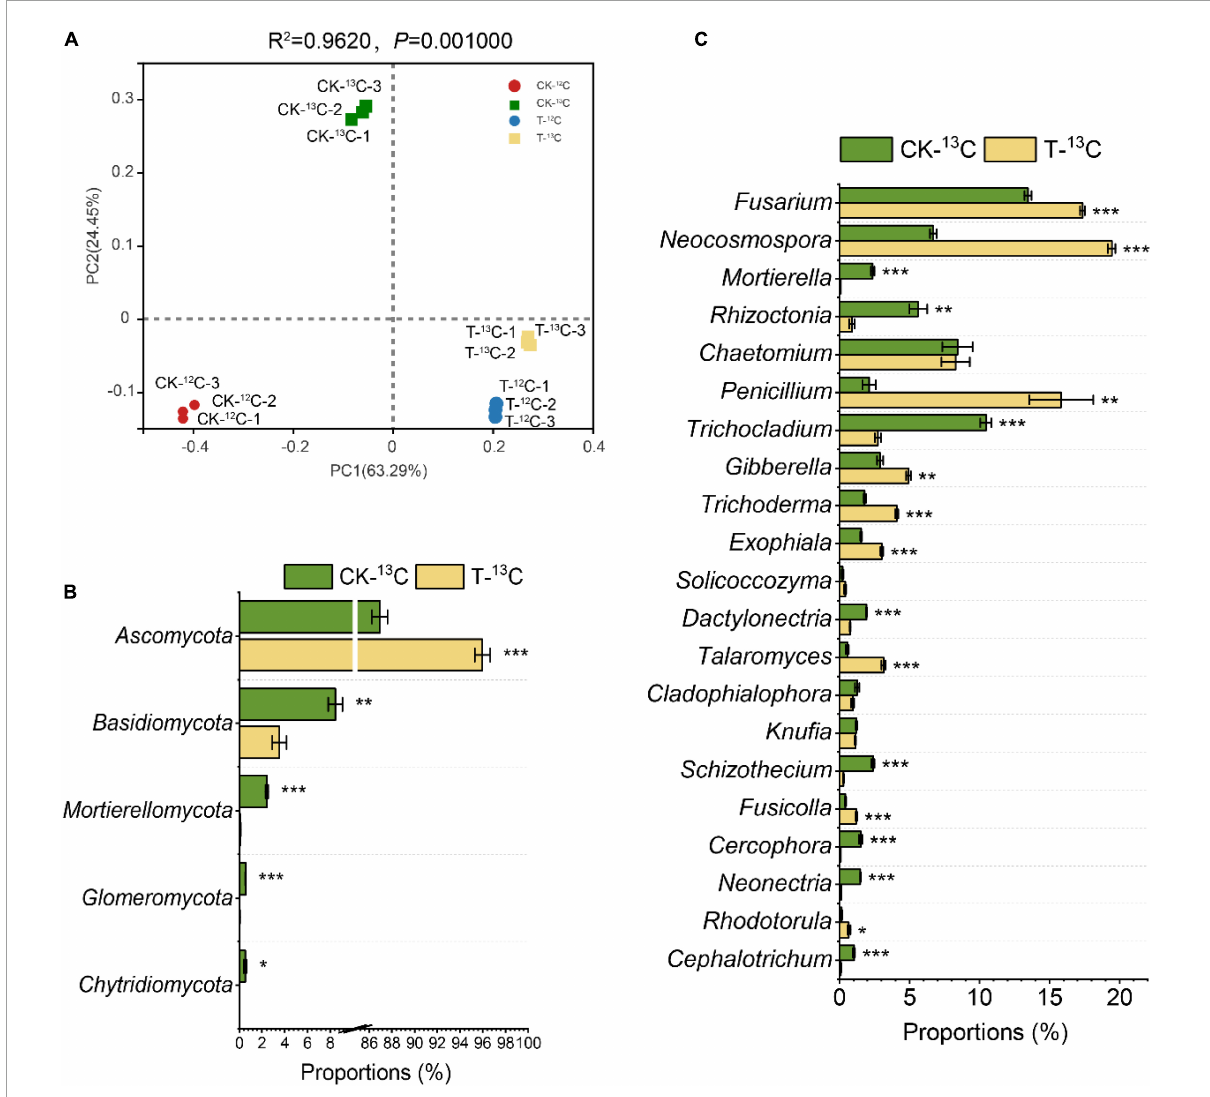
FIGURE5 (A) Principal co-ordinates analysis based on Bray–Curtis distances of fungal communities in soil samples of 12 C and 13 C-labeled DNA under CK and 4-HBA treatments (T) (ADONIS test). (B) Relative abundance of different fungal taxa at the phyla level and major variations in soil samples between CK- 13 C and T- 13 C. (C) Relative abundance of different fungal taxa at the genus level and major variations in soil samples between CK- 13 C and T- 13 C. Bars represent means ± standard errors ( n = 3). The asterisk indicates significant differences between CK- 13 C and T- 13 C (Student’s t -test, * p < 0.05; ** p < 0.01; *** p <